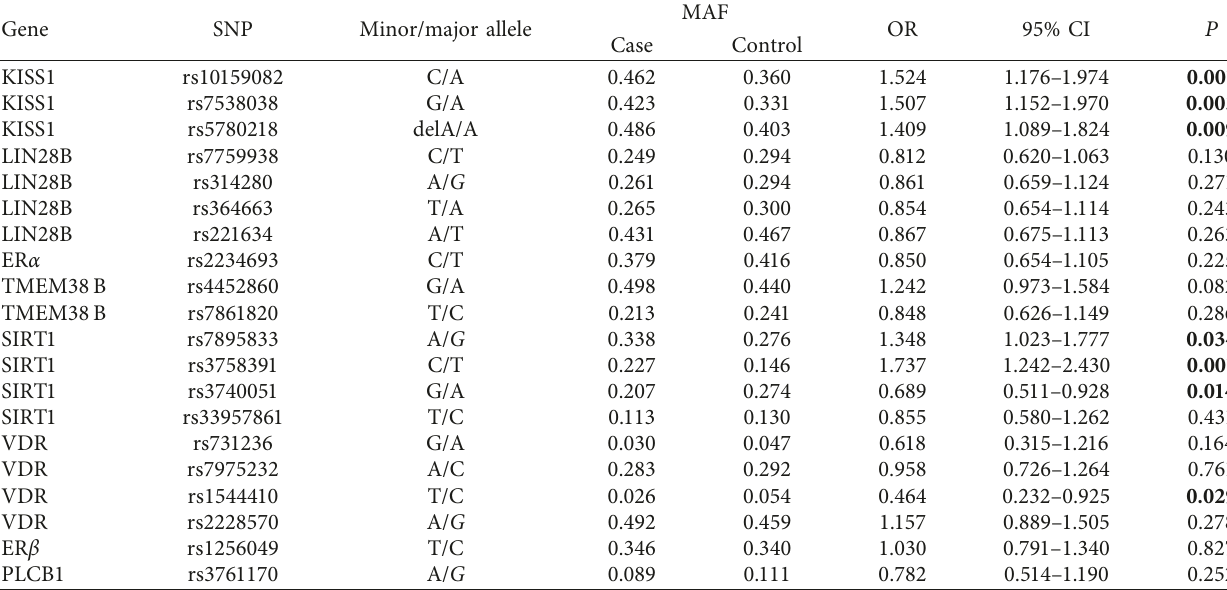
Table 3: Association analysis between the selected single nucleotide polymorphisms and central precocious puberty